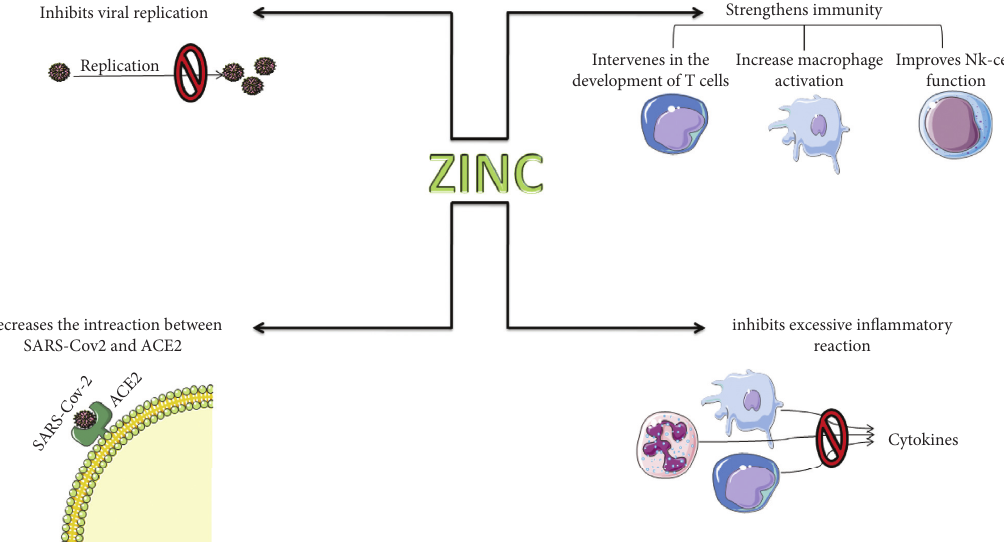
Figure 1: The role of zinc in the immune defense against